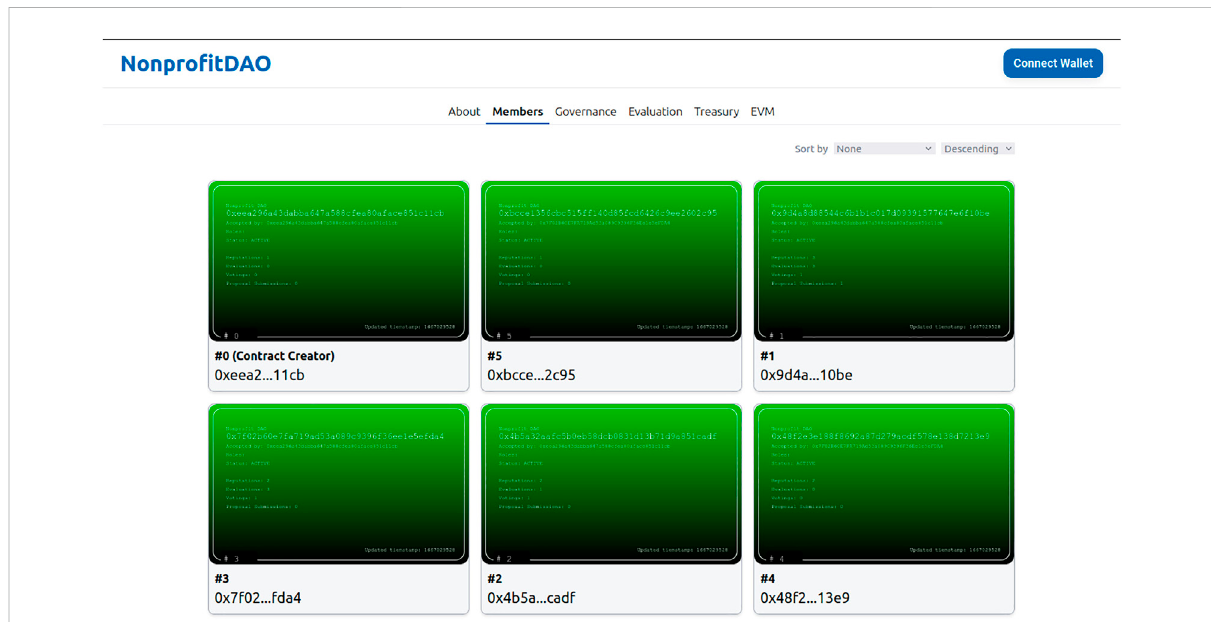
FIGURE 9 The members section in the front-end software. The SBRTs of all members can be viewed by anyone on the Internet, along with all